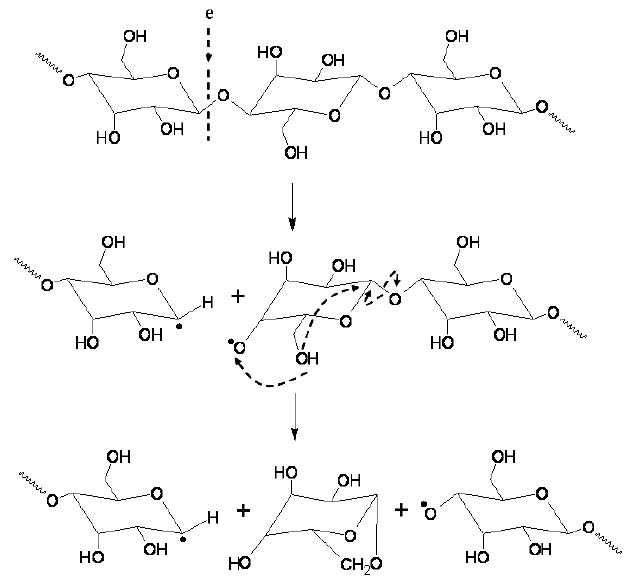
Figure 9. The scheme of cellulose degradation under action of high-energy electrons in the EBP.